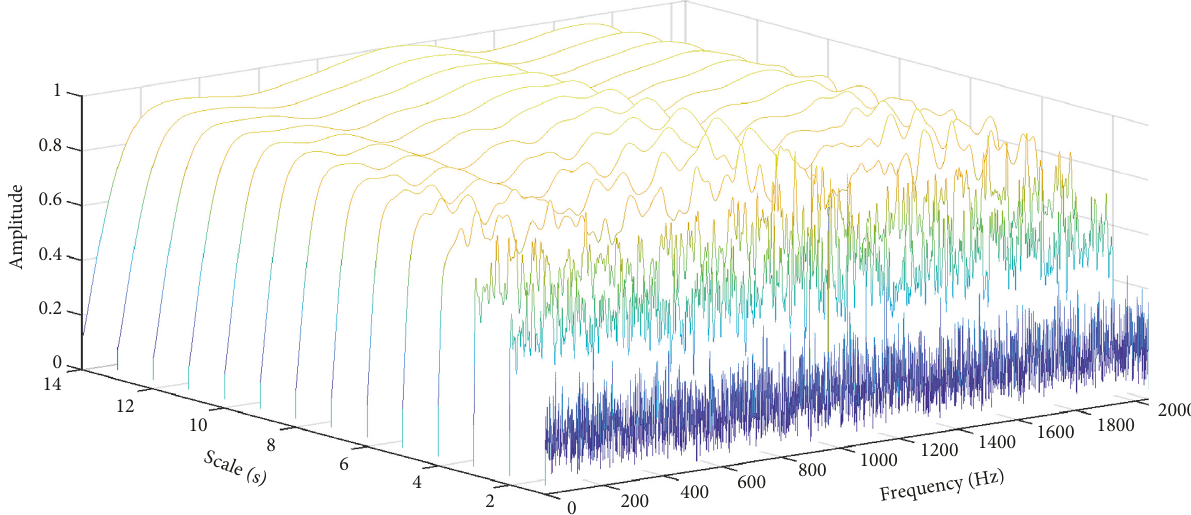
Figure 3: The discrete SSRs L( f , s) with different scale